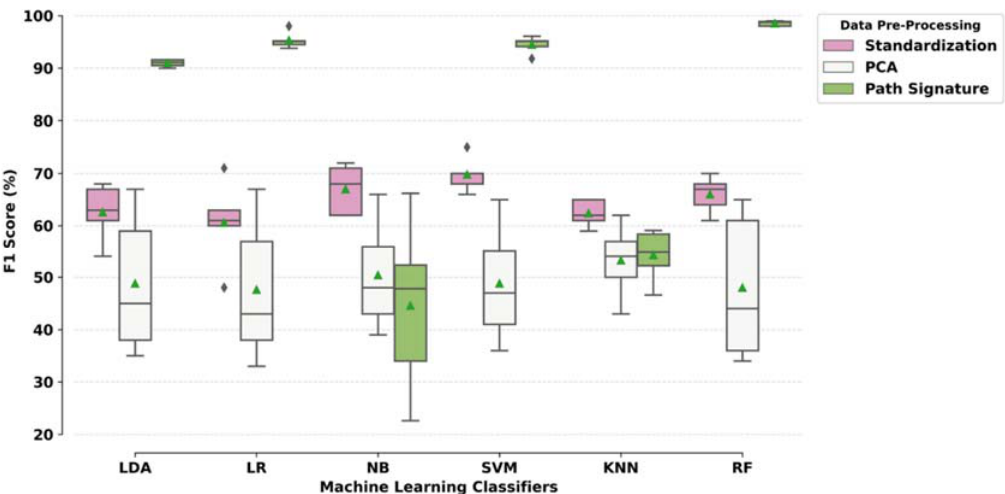
Figure 5. Classification performance of the ML models based on the F1 score. LDA: linear discriminant analysis; LR: logistic regression; NB: Naïve Bayes; SVM: support vector machine; KNN: k-nearest neighbour; RF: random forest.